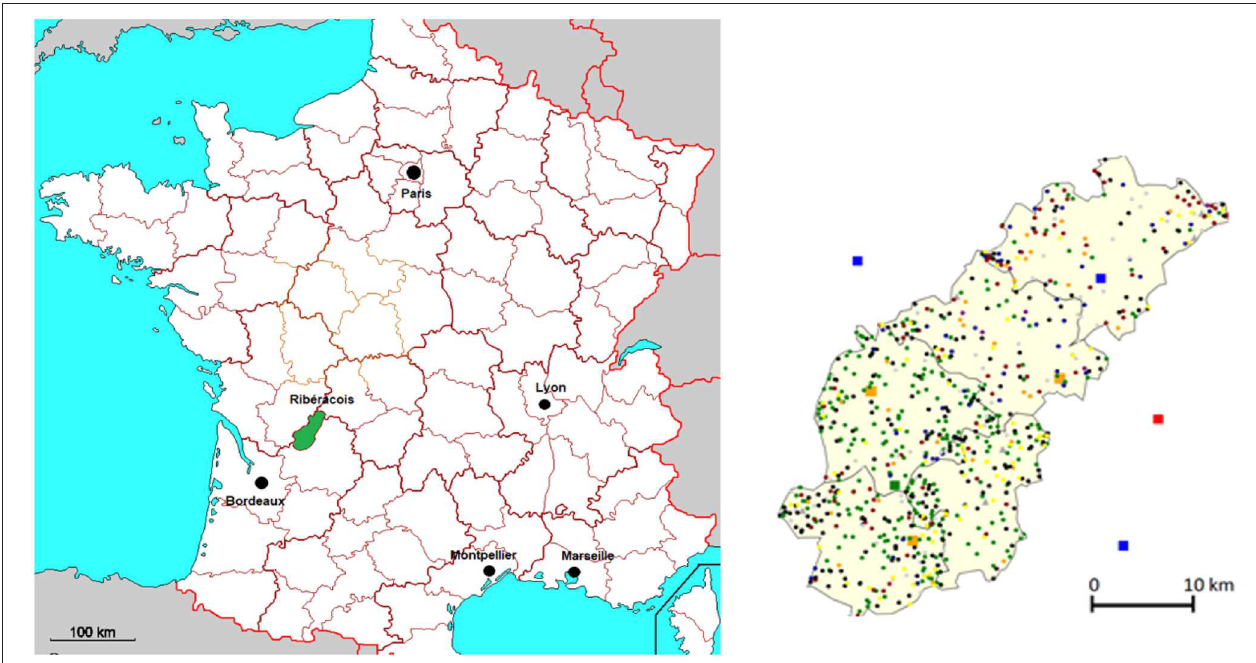
FIGURE 1 | Geography of the “Ribéracois” district. On the left, location of the district in Dordogne, France. On the right, map of the district and key agents in FAN. Farms are represented by circles colored with their type (green for arable; blue for dairy; red for beef cows; purple for mixed cattle; black for mixed crop-livestock; yellow for horticultural; orange for monogastrics; and gray for ovine and caprine). Squares represent food industries (yellow: feed collectors; blue: milk industries; green: fruits and vegetables industry; red: slaughterhouse).